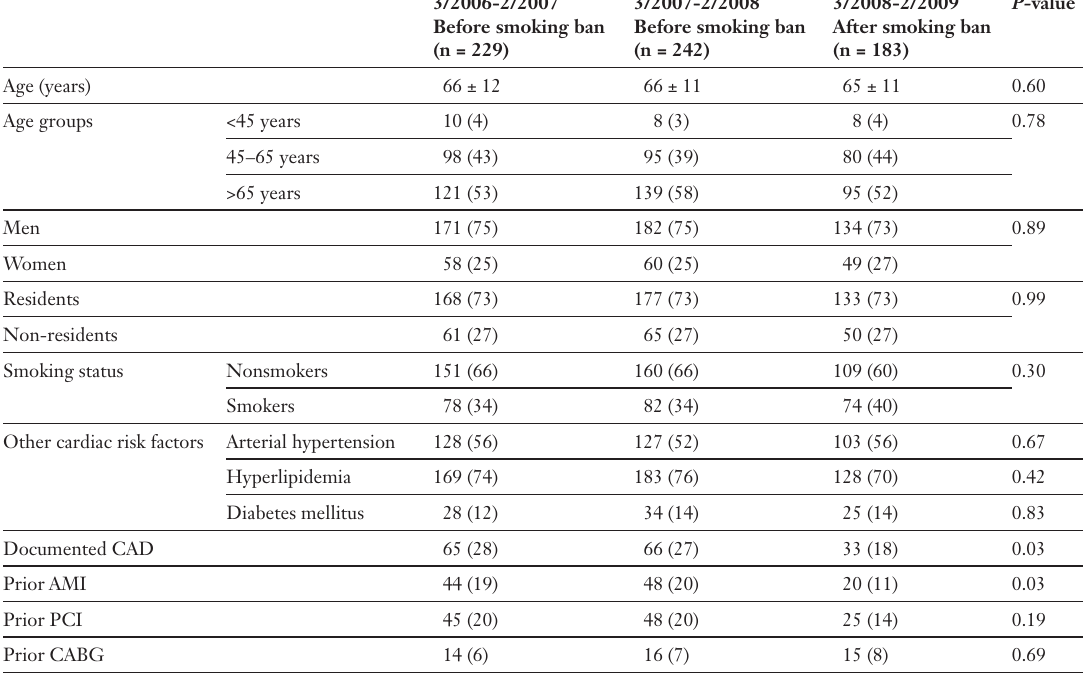
Characteristics of the study population in the two years before (3/2006-2/2007 and 3/2007-2/2008) and the year after (3/2008- 2/2009) implementa- tion of the public smoking